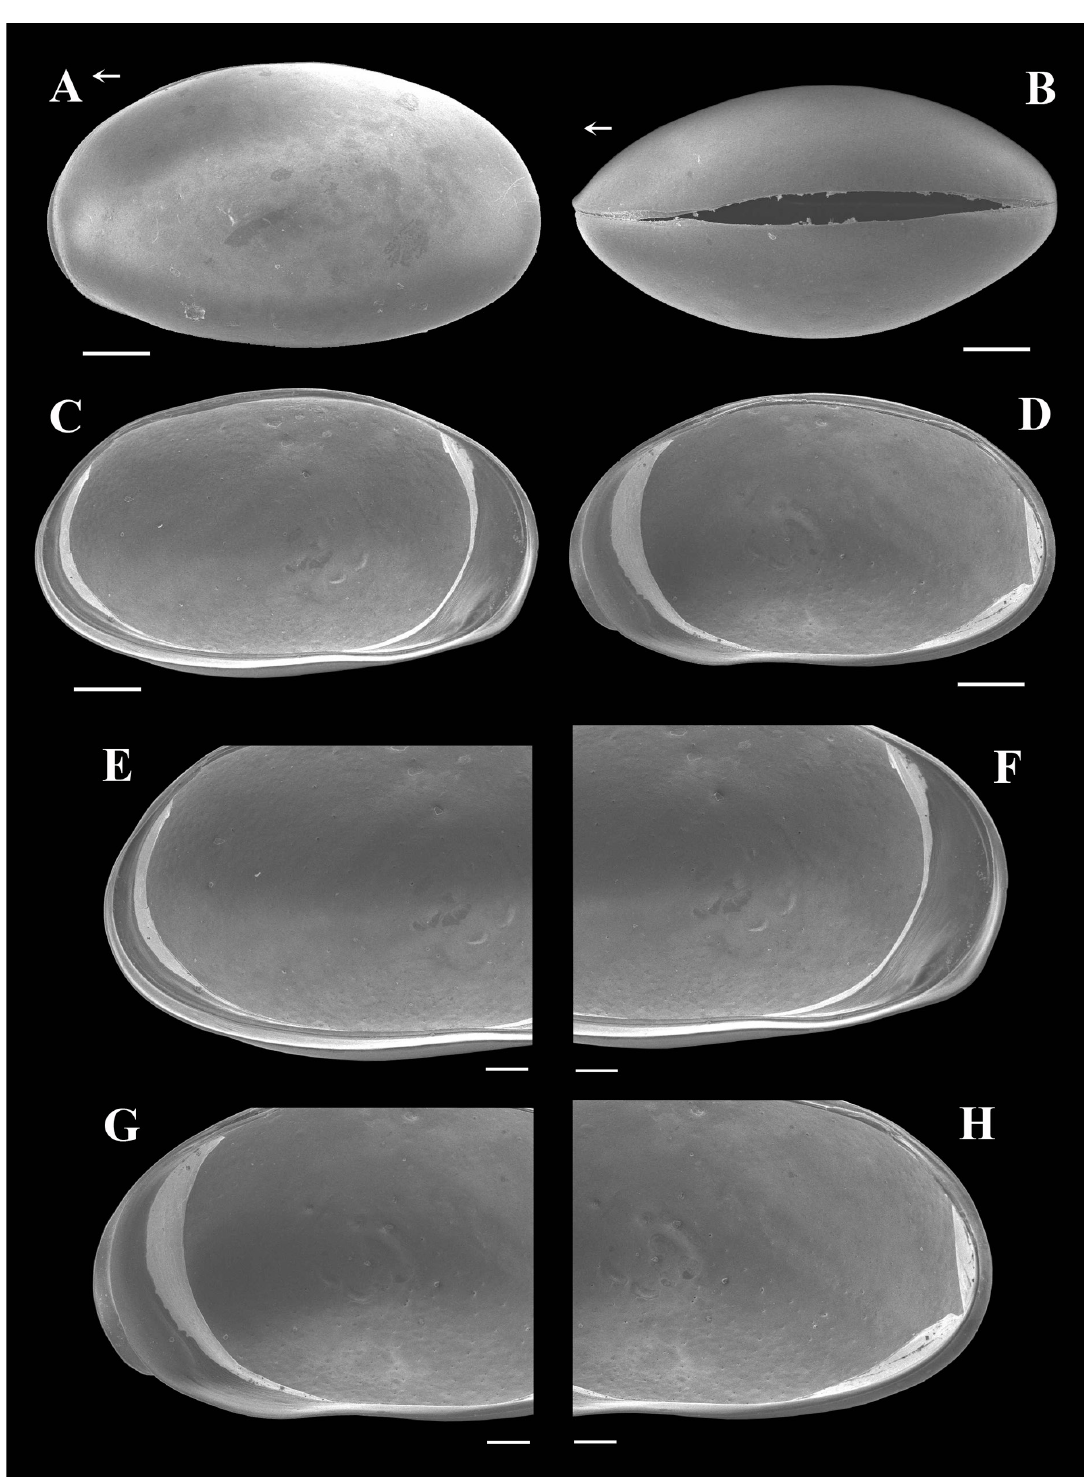
Fig. 7. Strandesia prachuapensis sp. nov., ♀. A . Paratype (MSU-ZOC.304). B . Paratype (MSU- ZOC.305). C–H . Holotype (MSU-ZOC.303). A . Cp, left lateral view. B . Cp, dorsal view. C . LV, internal view. D . RV, internal view. E . Posterior part of LV. F . Anterior part of LV. G . Anterior part of RV. H . Posterior part of RV (idem). Scale bars: A–D = 200 μm; E–H = 100 μm. Arrows point toward the anterior